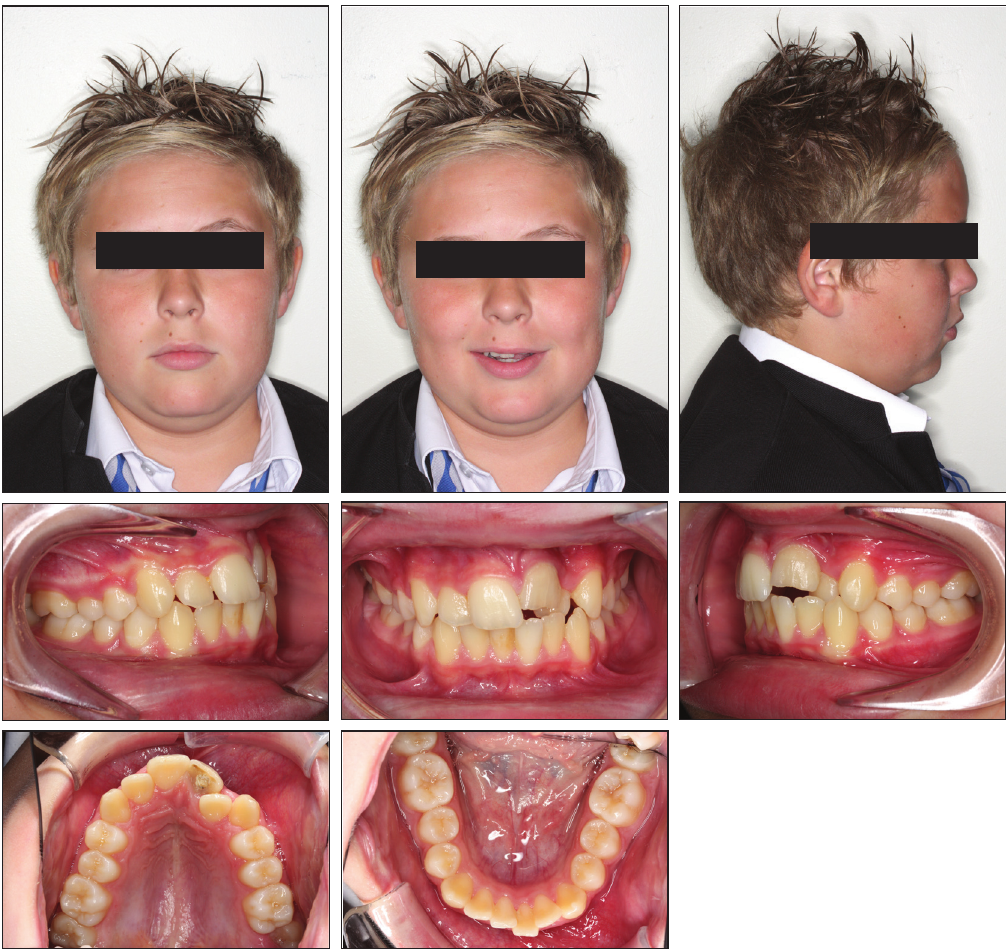
Figure 1. Pre-treatment extra-oral and intra-oral photographs. Note the posed display of the upper left permanent central incisor.